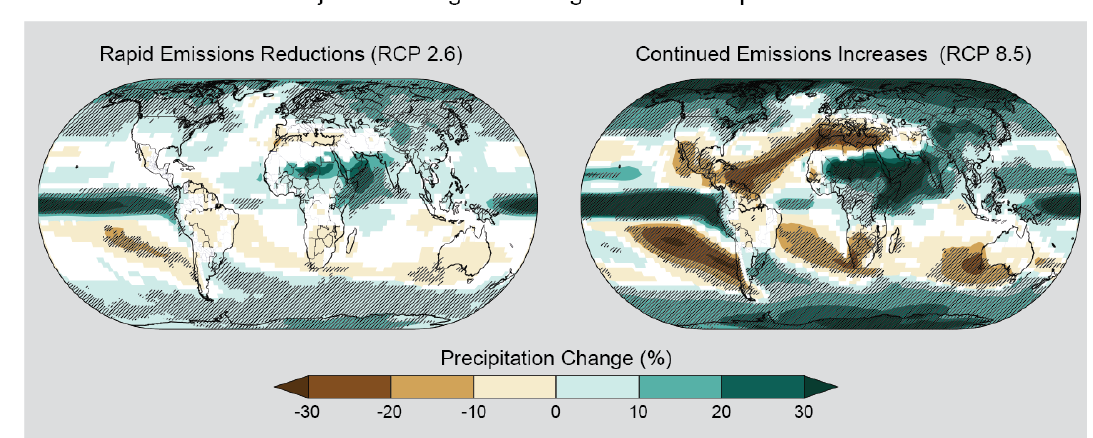
Figure 5. Projected change in average annual precipitation, reproduced from the 3rd National Climate Assessment (Walsh et al., 2014). Gray hatching represents statistically significant changes that are also consistent across multiple